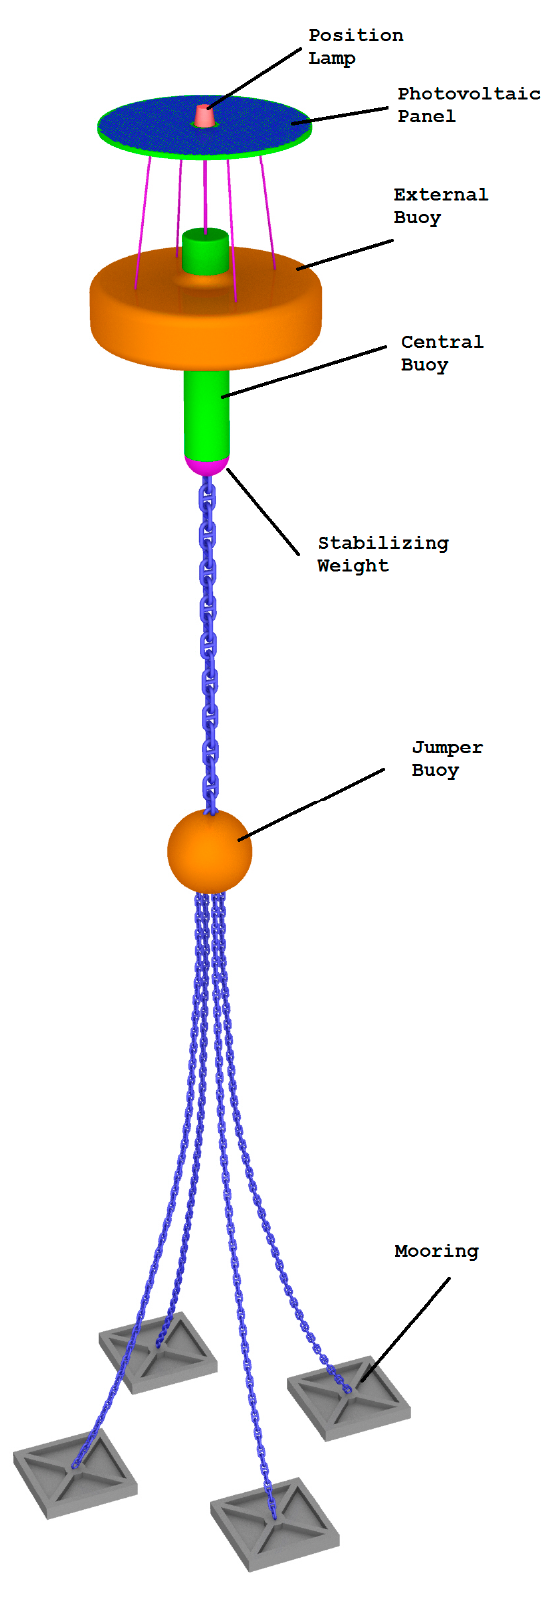
Figure 12. Graphical representation of the DEIM Point Absorber.